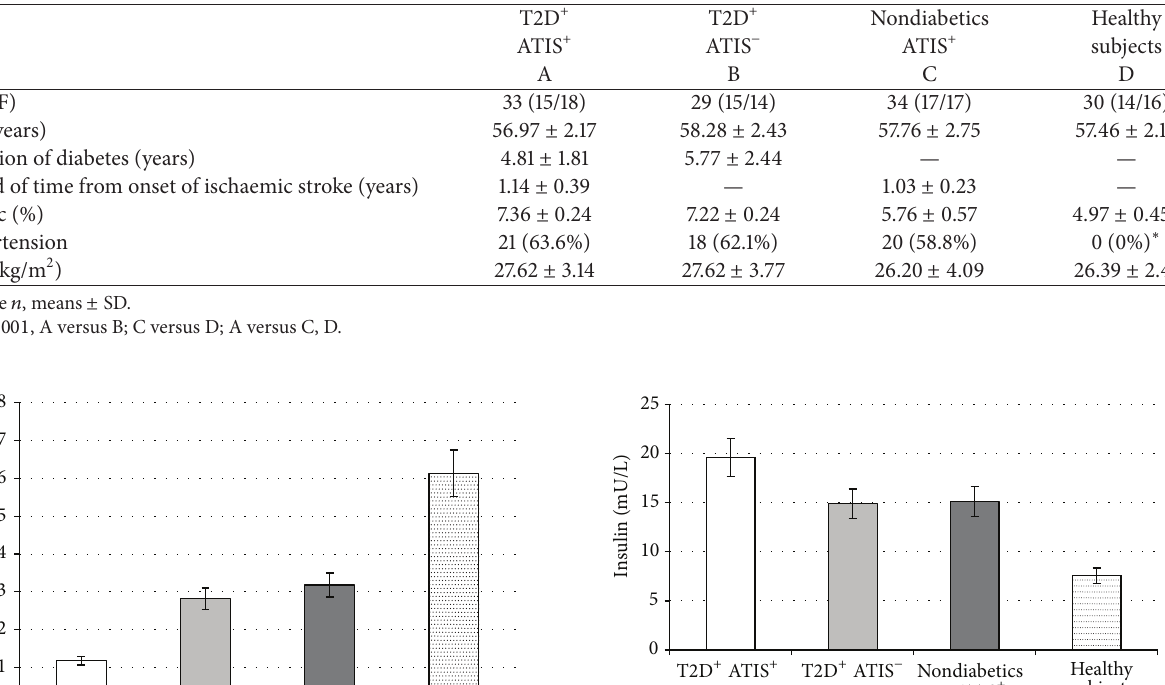
Table 1: Clinical characteristics of type 2 diabetes (T2D) patients and nondiabetics with and without atherothrombotic ischemic stroke (ATIS).